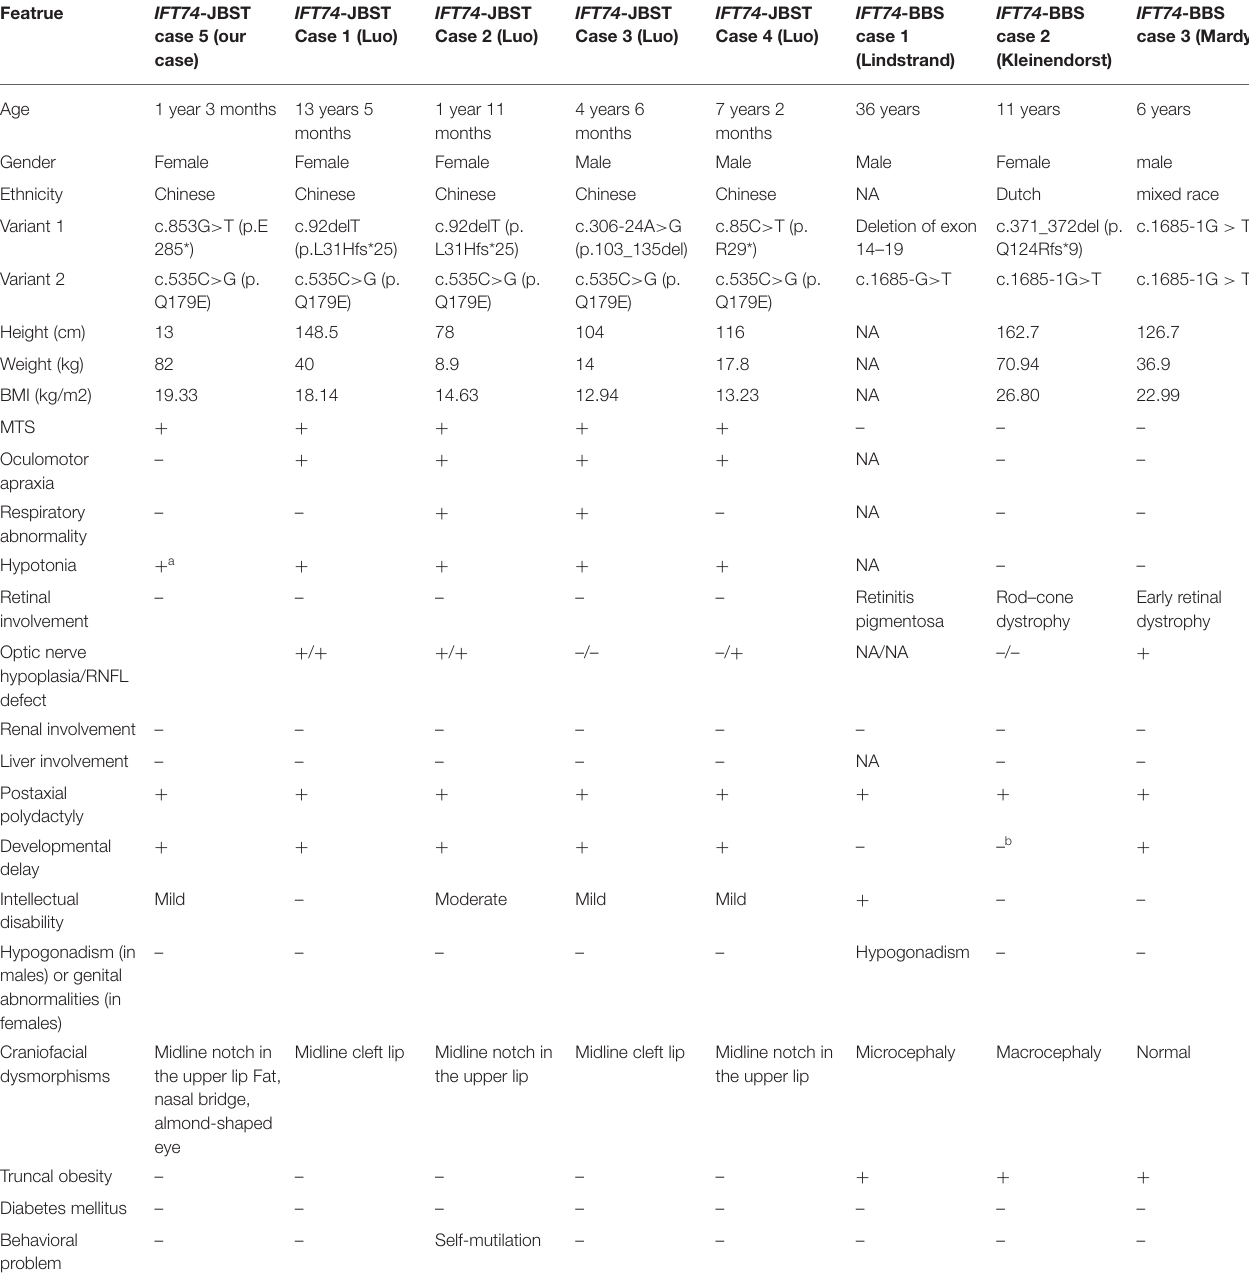
TABLE 1 | Clinical features of patients with biallelic IFT74 variants.